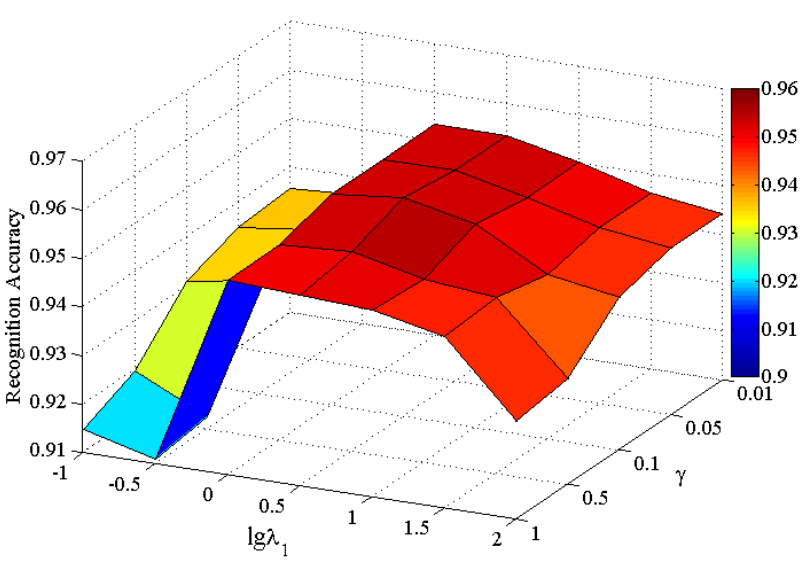
Figure 5. The recognition accuracy across the range of the